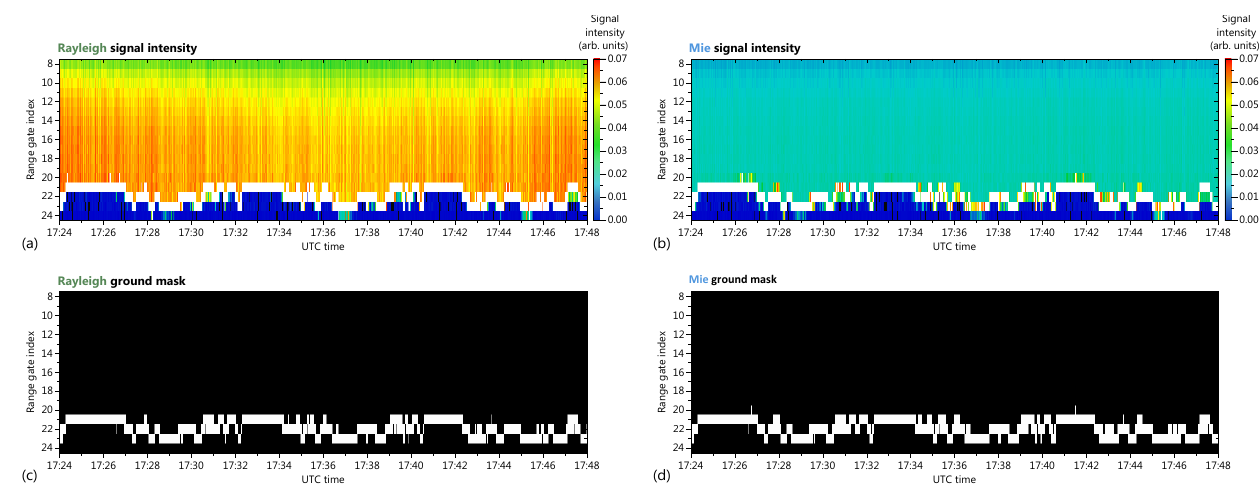
Figure 4. Ground detection during the response calibration performed over Iceland on 15 October 2016 between 17:24 and 17:48UTC. (a) Signal intensities measured with the A2D Rayleigh channel versus time and the range gates 8 to 24 on measurement level. (b) Mie signal intensity including Rayleigh background on measurement level. The intensities are range-corrected and scaled to the integration time of the respective range gates. Range gates 8 to 19 have a length of 592m, while range gates 20 to 24 have a length of 296m. Bins with signal intensities exceeding the maximum of the respective colour scale are printed in white. The Rayleigh and Mie ground masks resulting from the developed ground detection scheme are depicted in panels (c) and (d) , respectively. White bins are identified as ground bins and thus considered for the determination of the ground response